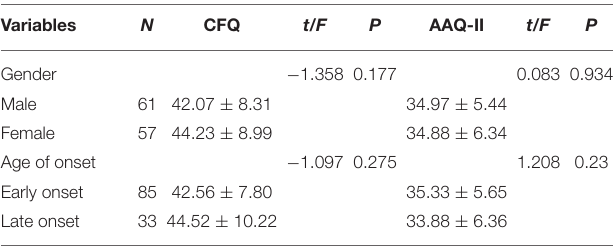
TABLE 2 | Comparison of the scores of experiential avoidance and cognitive fusion among different demographic characteristics of obsessive–compulsive disorder patients (scores, ‘ x ± s